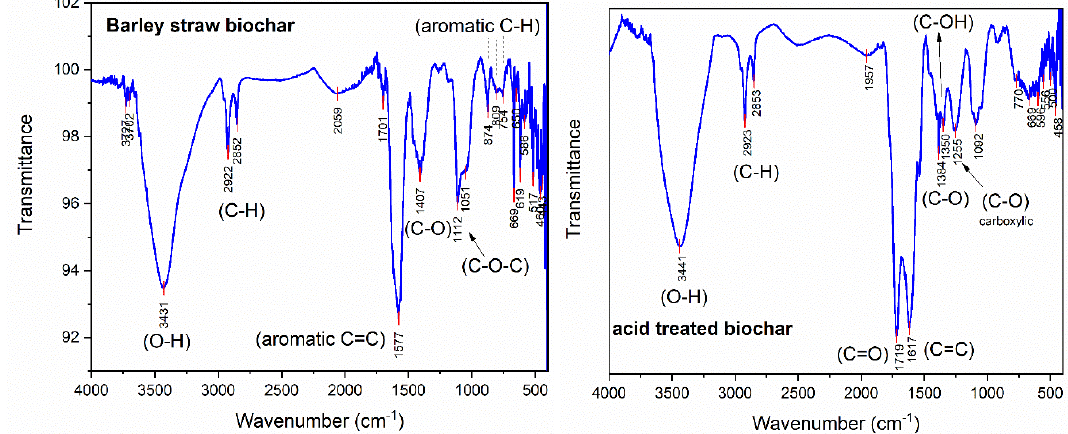
Fig. 3. The FTIR spectra of biochar and acid treated biochar.